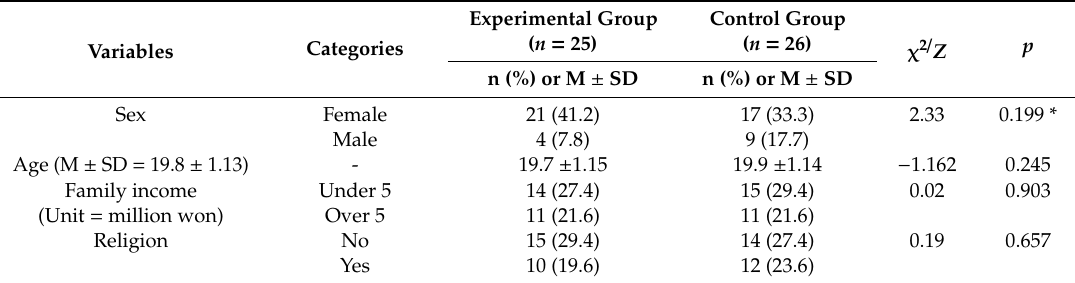
Table 2. Homogeneity test of general characteristics.